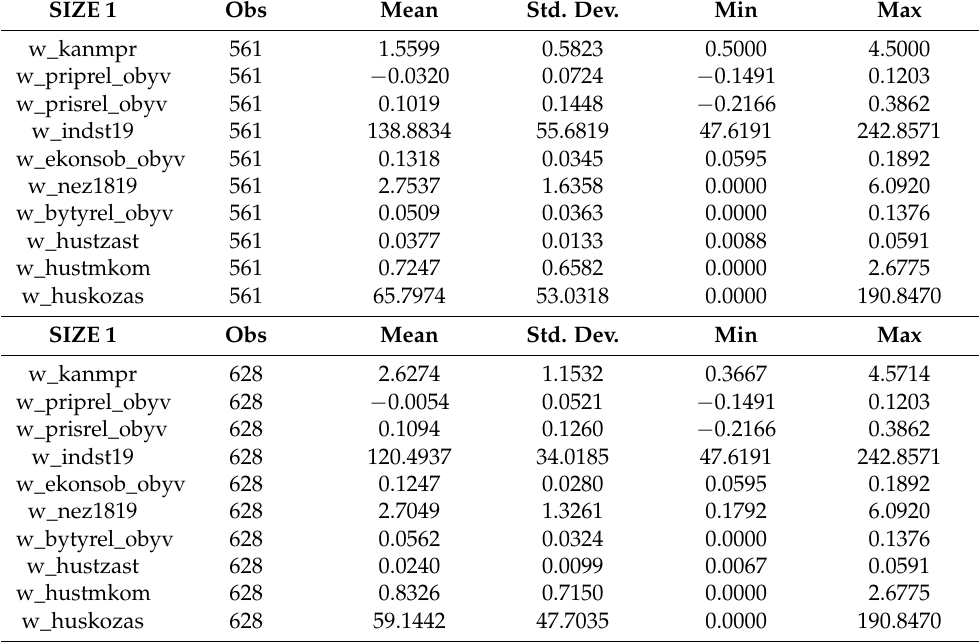
Table A2. Indicators of the present state of the municipalities—descriptive